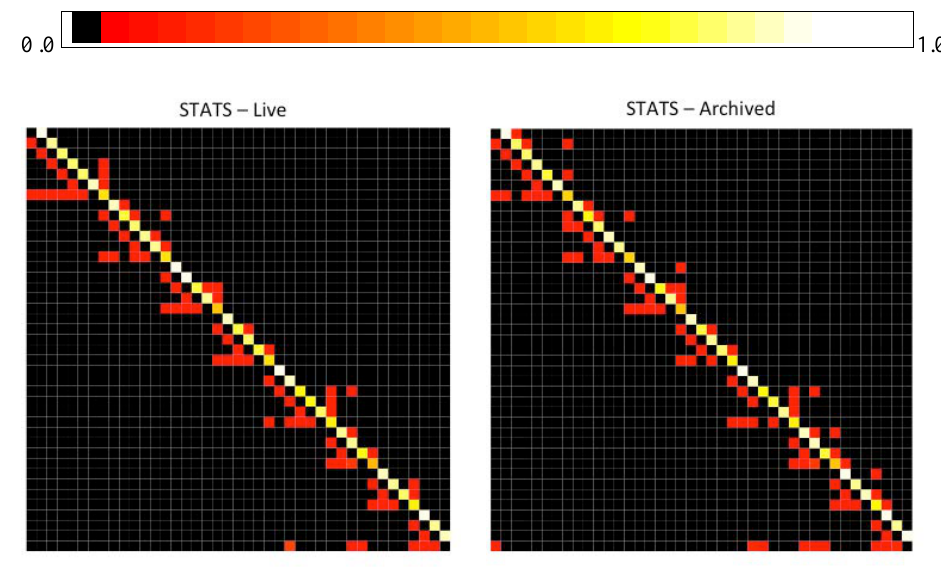
Figure 3. Video transition matrices for STATS, intent category all